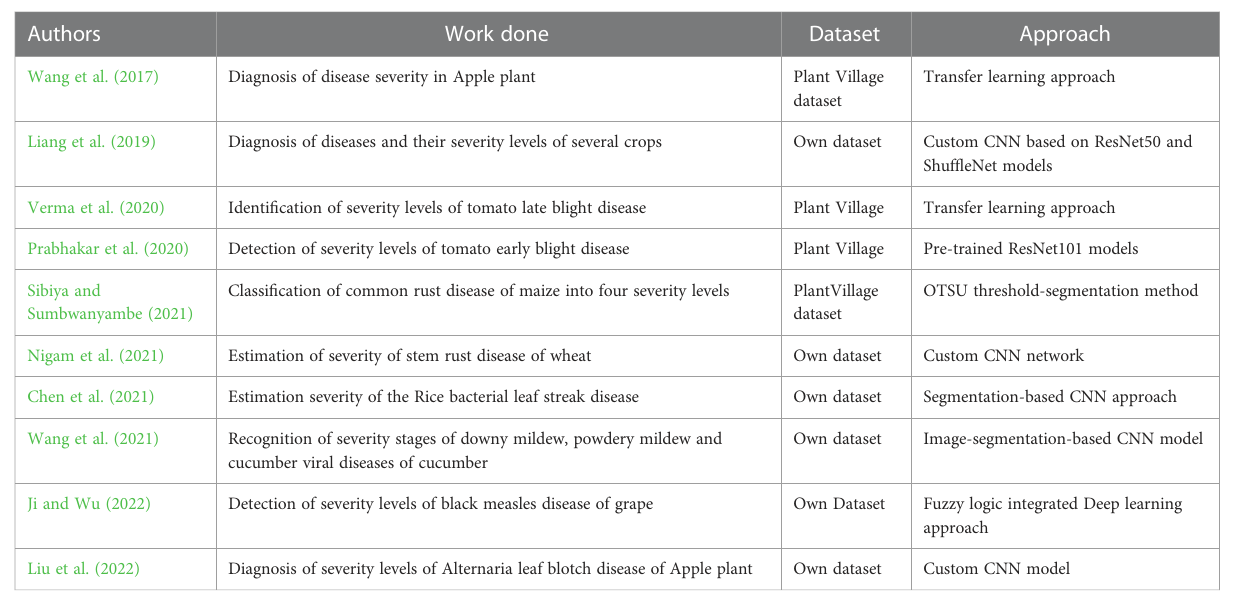
TABLE 1 A brief summary of related